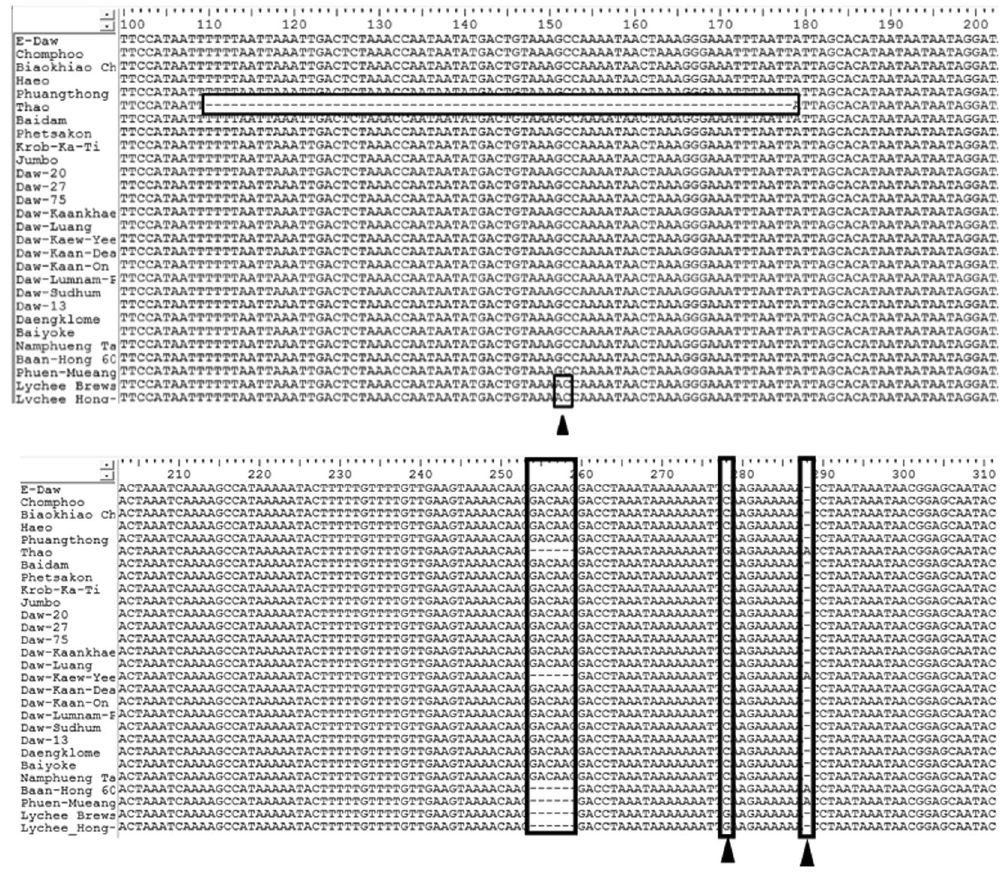
Figure 2. Multiple sequence alignment result of trnH-psbA gene. The InDel mutation is in the box and base substitution are indicated by black